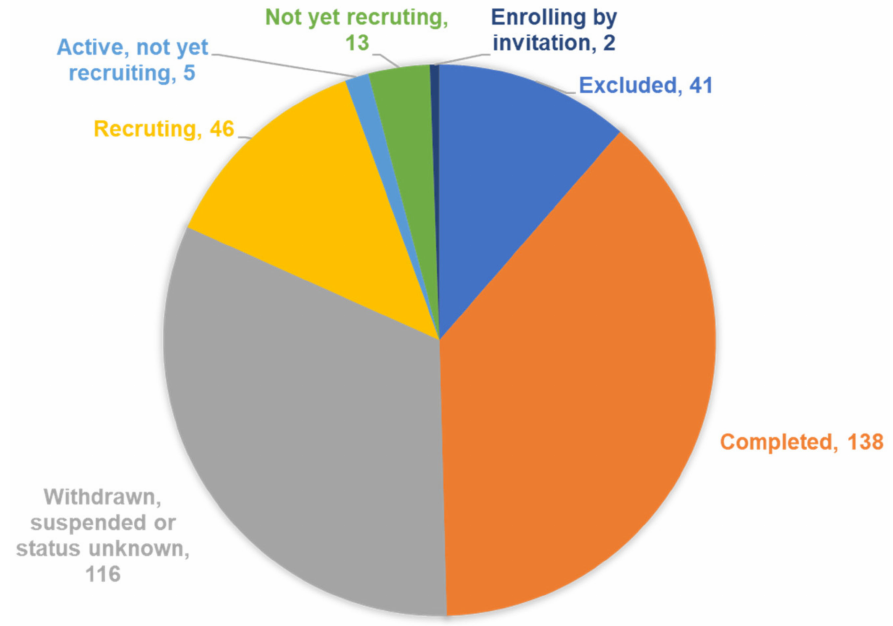
Figure 1. Status of clinical trials in TBI listed on ClinicalTrials.gov as of 3 December 2021.